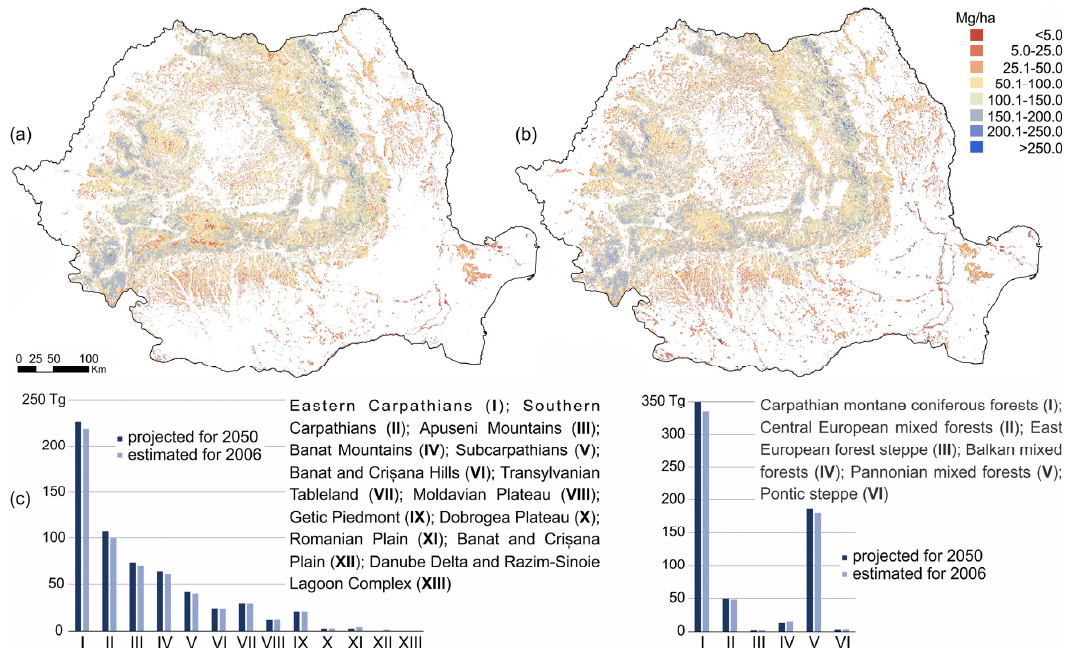
Figure 8. The projected AGFCS for 2050 ( a ) compared to the estimated value for 2006 ( b ), and their variation at the major landform units and the major vegetation ecoregions ( c ).